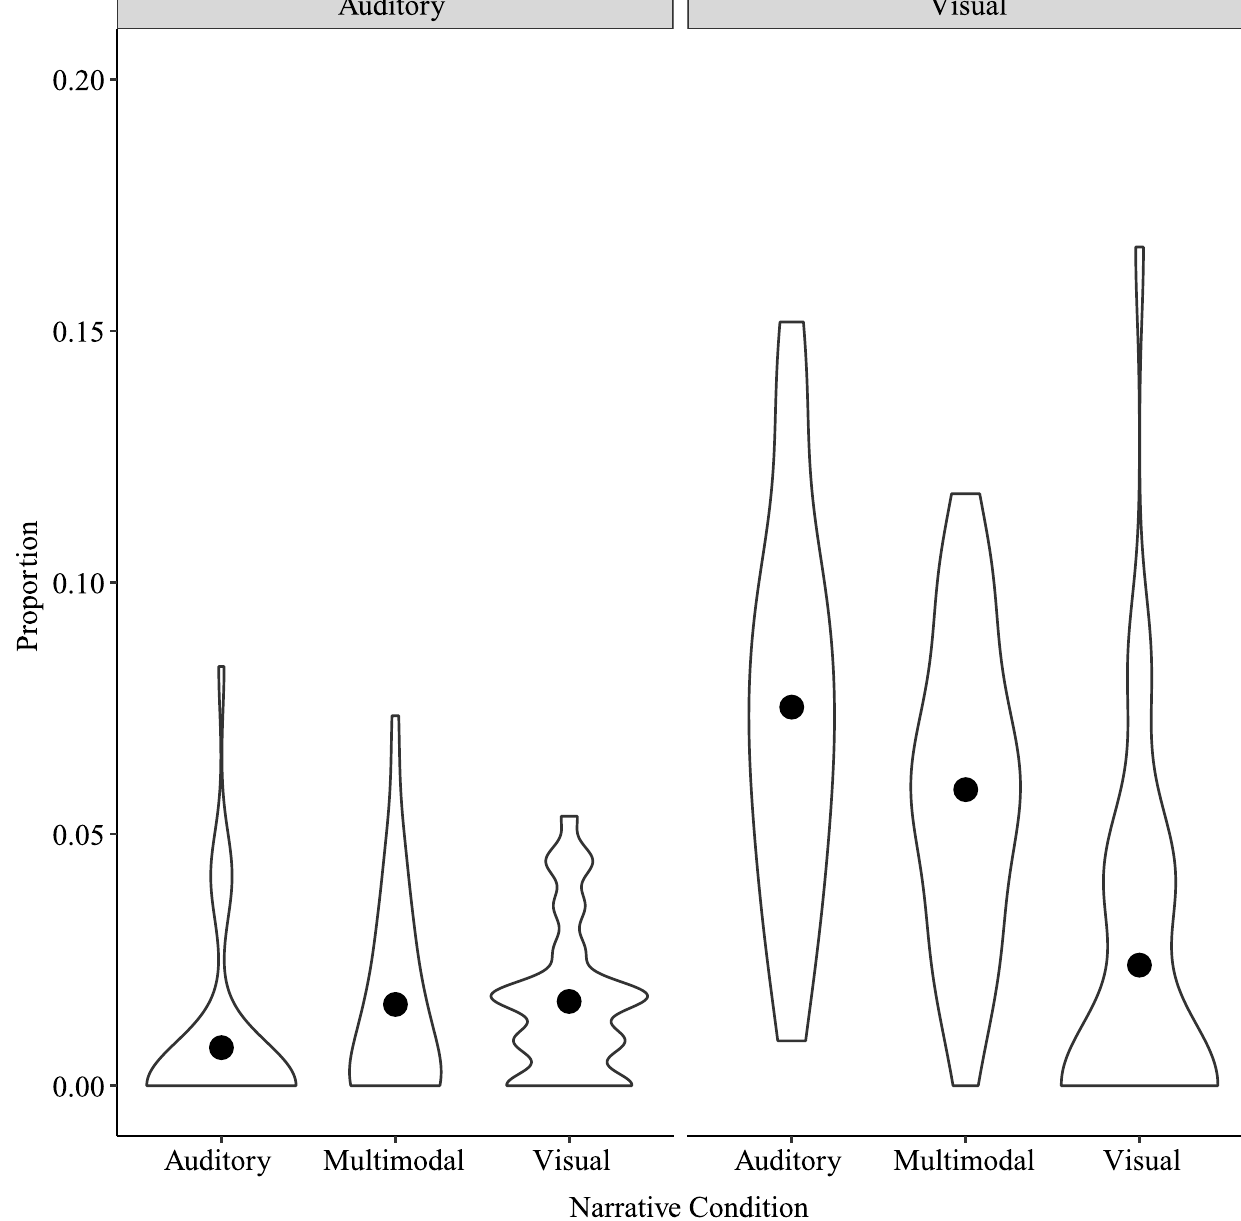
Fig 8. False recollections by Narrative Condition and Misremembered Detail Type for Study 2. Points show means for each Narrative Condition by Misremembered Detail Type. Note the y-axis scale, indicating very few false recollections.